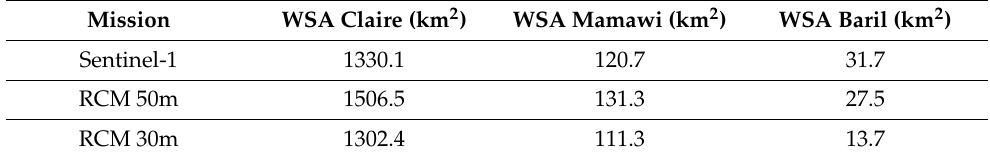
Table 5. Water surface area (WSA) comparison of Sentinel-1 (21 August), RCM-50m (24 August) and RCM-30m (23 August) for lakes Claire, Mamawi and